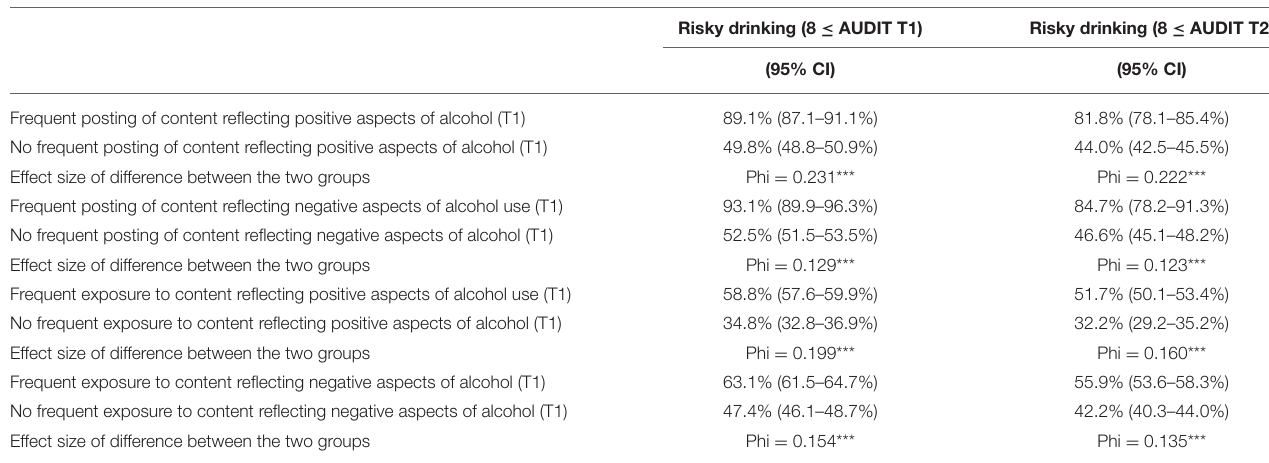
TABLE 3 | Distribution of risky drinking among the frequent disclosure and exposure